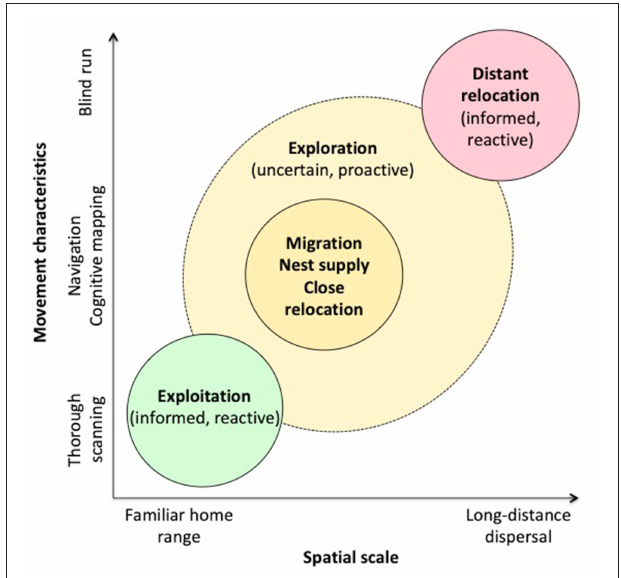
FIGURE 1 | Relationships between movement characteristics and spatial scale for different types of activity in animals, based on the movement ecology concepts used in this paper. Movement characteristics are distributed along a gradient from slow and sinuous strongly organized by stimuli associated with resources (food, sexual partners, social partners, commodities) to more rapid and less sinuous movement organized by complex orientation mechanisms (navigation, cognitive map) associated with migration between habitat patches or exploration to lastly rapid and straight movement across unknown areas associated with dispersal and definitive long-distance relocation (emigration). X-axis gives the related spatial scales from familiar home range to long-distance dispersal. In species with habitat supplementation or complementation (patchy resources, complex lifecycles, exploitation of contrasted habitats), movements between habitat patches are governed by complex orientation mechanisms, such as navigation or cognitive mapping that reduce sinuosity and increase speed (migrations, nest supply). Exploratory movements have also intermediate characteristics since they are related to environment sampling usually for resources linked to homeostasis and they can lead to near relocation. They can be promoted by specific motivation (proactive behavior with latent